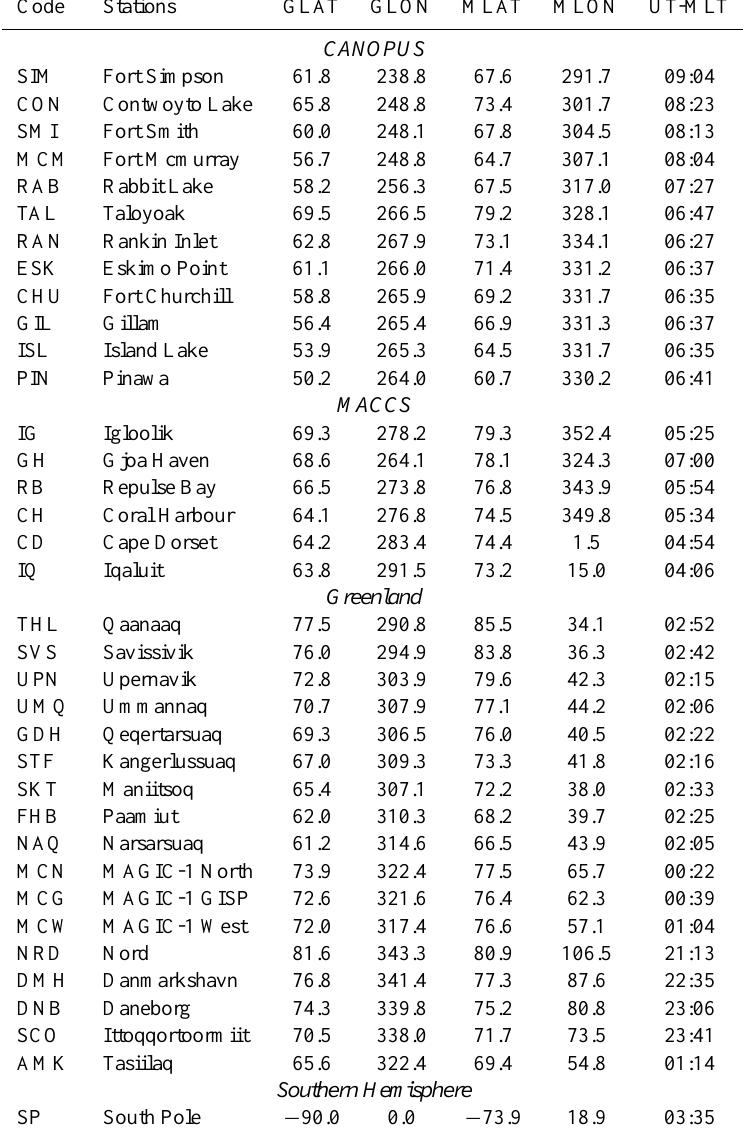
Table 1. Geographic and geomagnetic coordinates of magnetometer stations Code